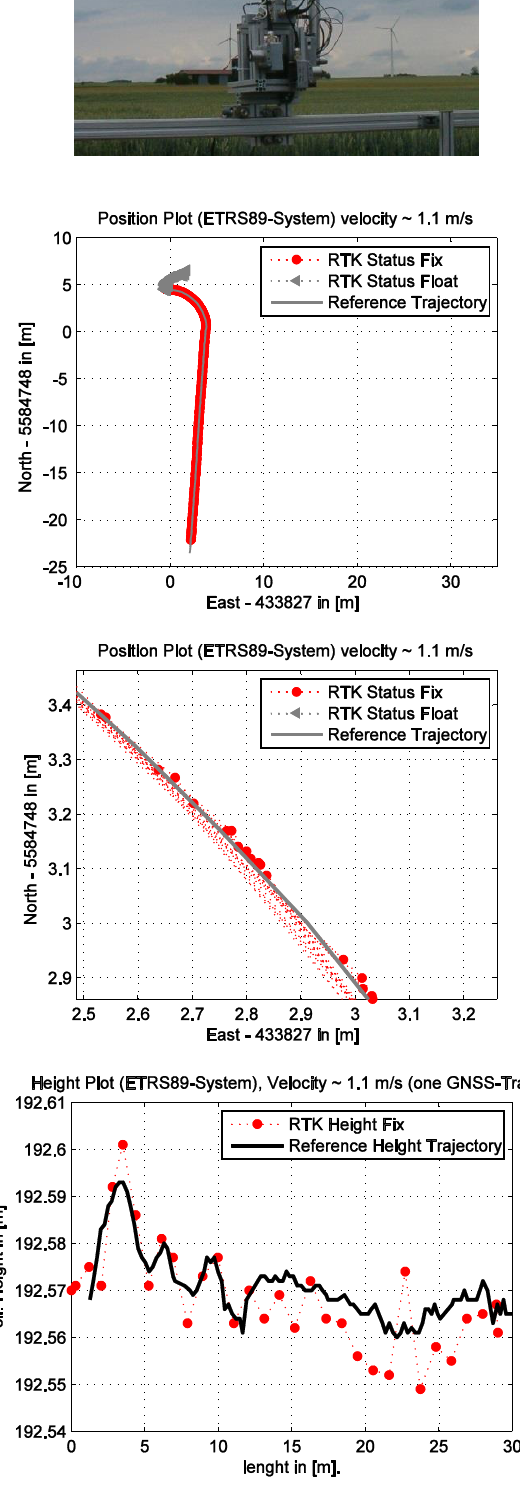
Figure 2, 3D-Navigation with the Low-cost RTK GNSS System at a Reference